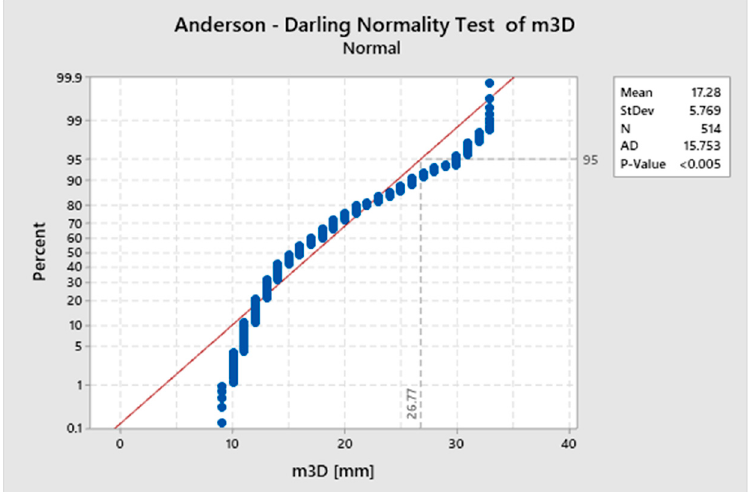
Figure 7. Anderson—Darling Normality Test of m 3D.